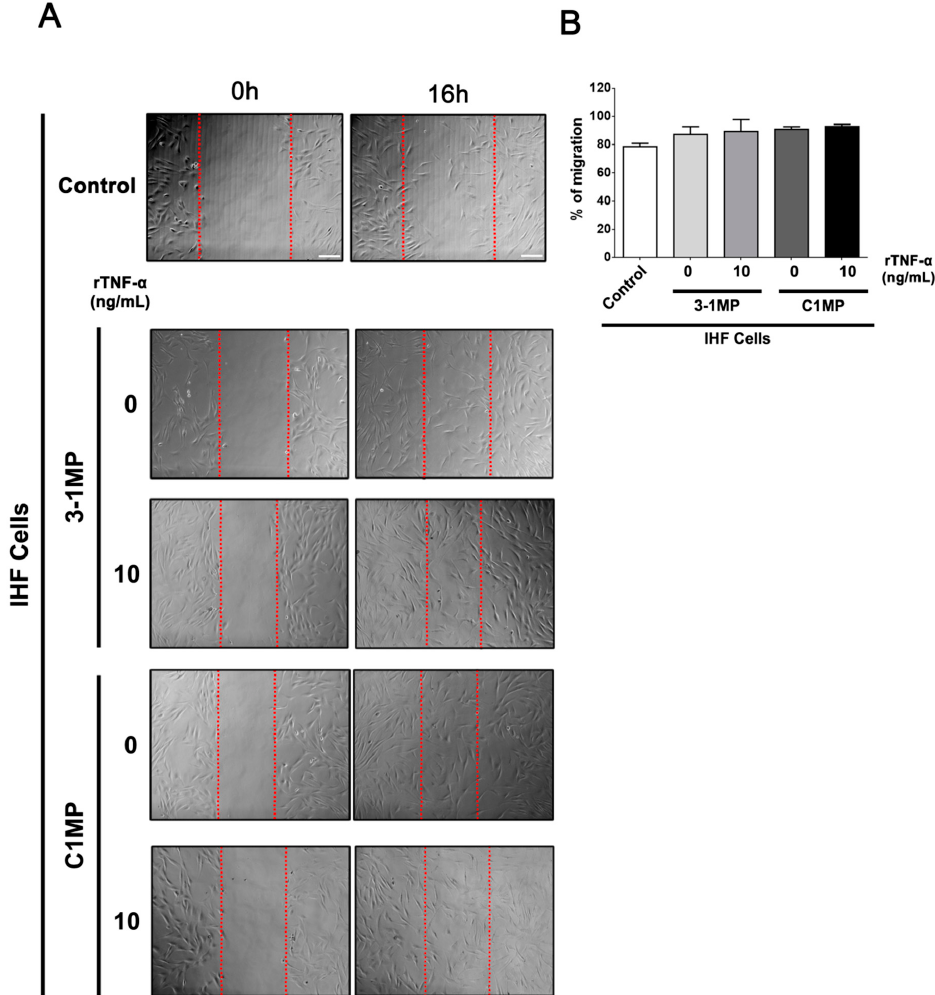
Figure 6. Analysis of IHF cell line migration after incubation with (microparticles (MP) derived from parental and MDR cell lines. IHF cells were scratched and immediately co-cultured with 3-1MP or C1MP secreted by rTNF- α treated tumor cells for 16 h. ( A ) Representative phase contrast images of scratched cells captured at 0 and 16 h time points. Dashed lines represent the limit of analyzed considered area. ( B ) Percentage of IHF cells migration under each condition after 16 h of treatment. Images were acquired using an Axio Observer.Z1, Zeiss, under 10 × magnification. Scale bar = 50 µ m. Data are means ± SD of three independent experiments. One-way ANOVA with Dunn’s posttest and t -tests were used to analyze the wound-healing results.